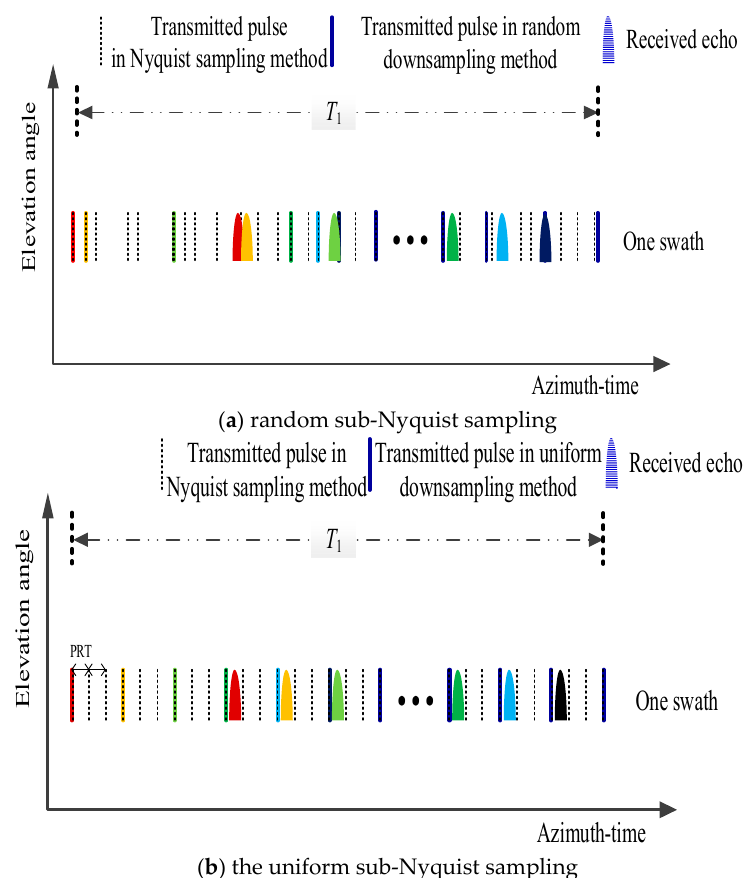
Figure 6. Illustration of sub-Nyquist sampling method for sampling duration T 1 . The dashed line denotes the Nyquist sample. The solid line denotes the sub-Nyquist sample in random and uniform sub-Nyquist sampling method randomly and uniformly selects from dashed line, respectively. ( a ) random sub-Nyquist sampling: the conflict between transmitted pulse and receiving echo. ( b ) uniform sub-Nyquist sampling: echo is completely received and has no conflict with the transmitted